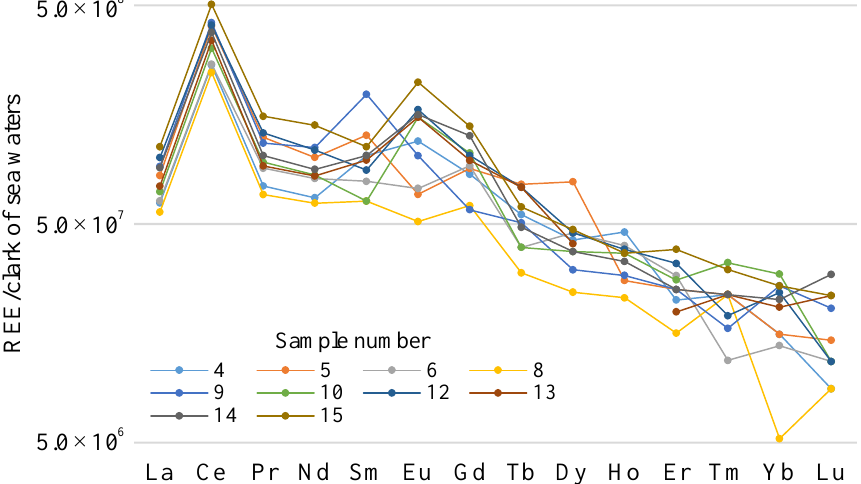
Figure 7. Distribution profile of rare-earth elements in lake water within Burabay rock mass (river- water Clarke is normalized).